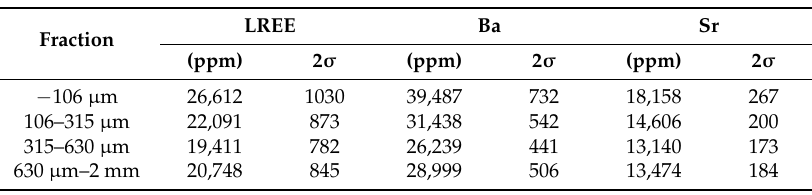
Table 3. Chemical analyses of the REE concentrate from the ten tests of gravity concentration; 2 σ is the error of the XRF analyses.